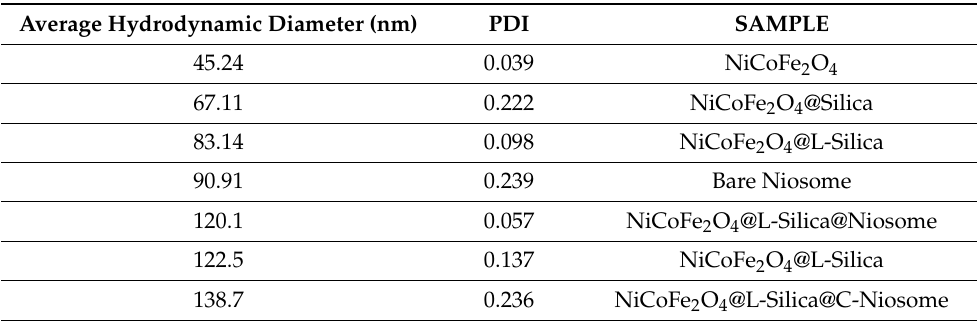
Table 1. Analysis of different samples by dynamic light scattering technique at different stages of development of the magnetic